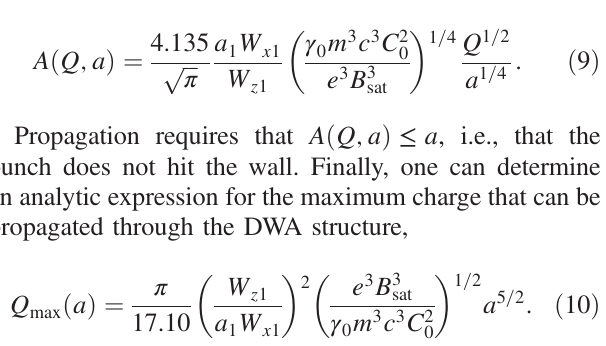
FIG. 4. Ratio of longitudinal and transverse wakefields W (blue line) and group velocity (red line) as functions of b=a (up) and dielectric constant (down). Both b=a and dielectric constant can affect group velocity. Higher group velocity leads to weaker transverse wakefields and weaker BBU effects.